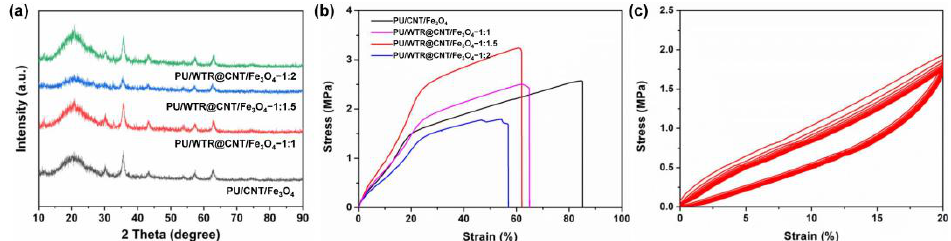
Figure 3. ( a ) XRD patterns and ( b ) tensile stress – strain curves of the PU/CNT/Fe 3 O 4 and PU/WTR@CNT/Fe 3 O 4 composite foams; ( c ) Ten stretch – release cycles of the PU/WTR@CNT/Fe 3 O 4